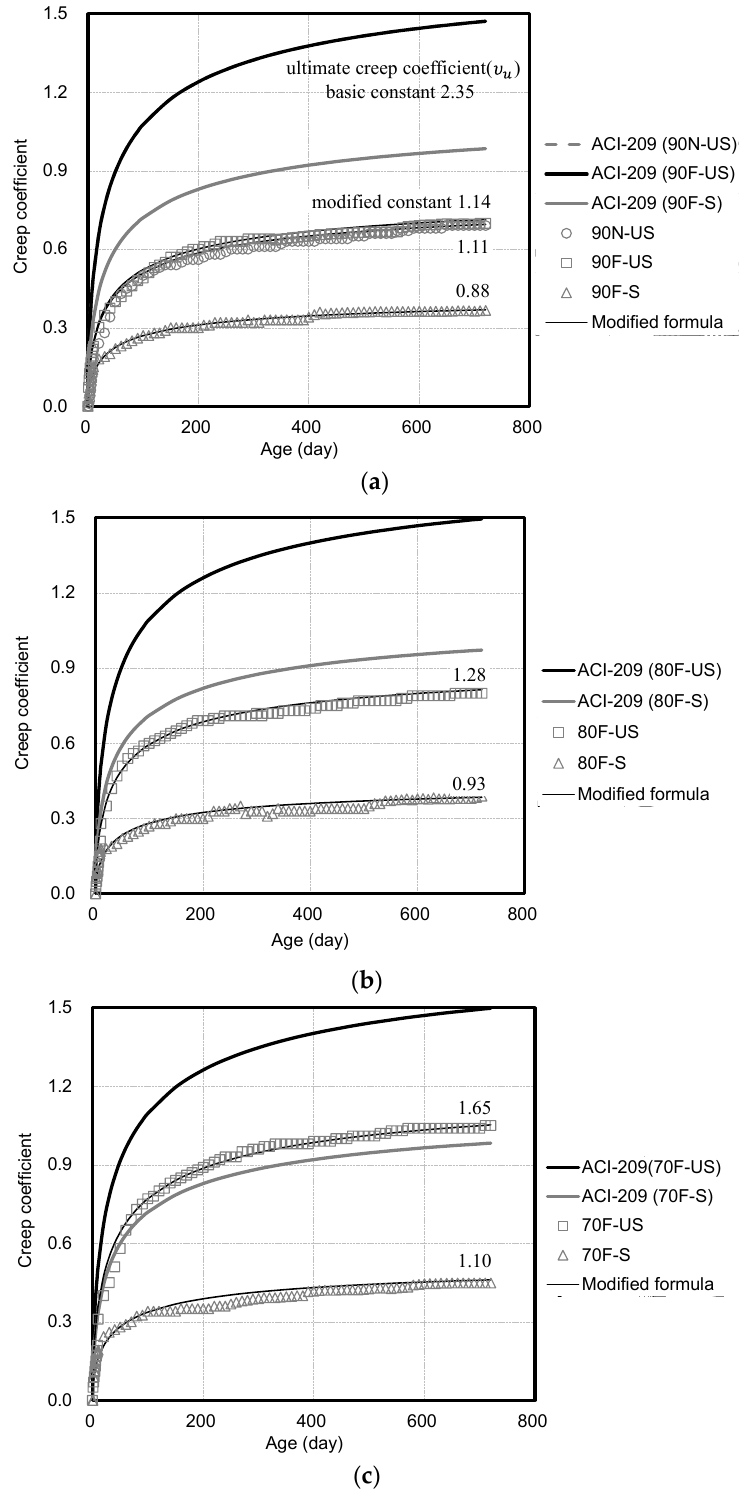
Figure 10. Compressive creep coefficient of high-strength concrete: ( a ) 90 MPa; ( b ) 80 MPa; ( c ) 70 MPa.